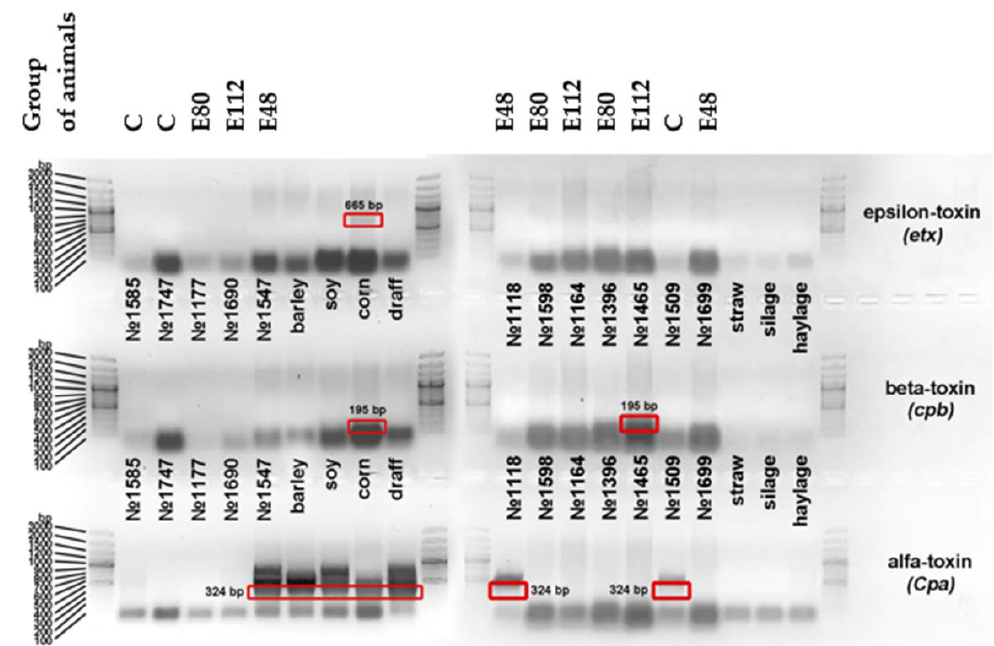
Figure 4. Agarose gel electrophoresis of alpha, beta and epsilon amplicons of C. perfringens toxin genes detected by polymerase chain reaction in rumen contents and feed ingredients (barley, corn, draff) of lactating cows (Avangard LLC, Russia): C—control group of cows, E48, E80, E112—experimental groups of cows, the symbol “№” and a four-digit number indicates the No.